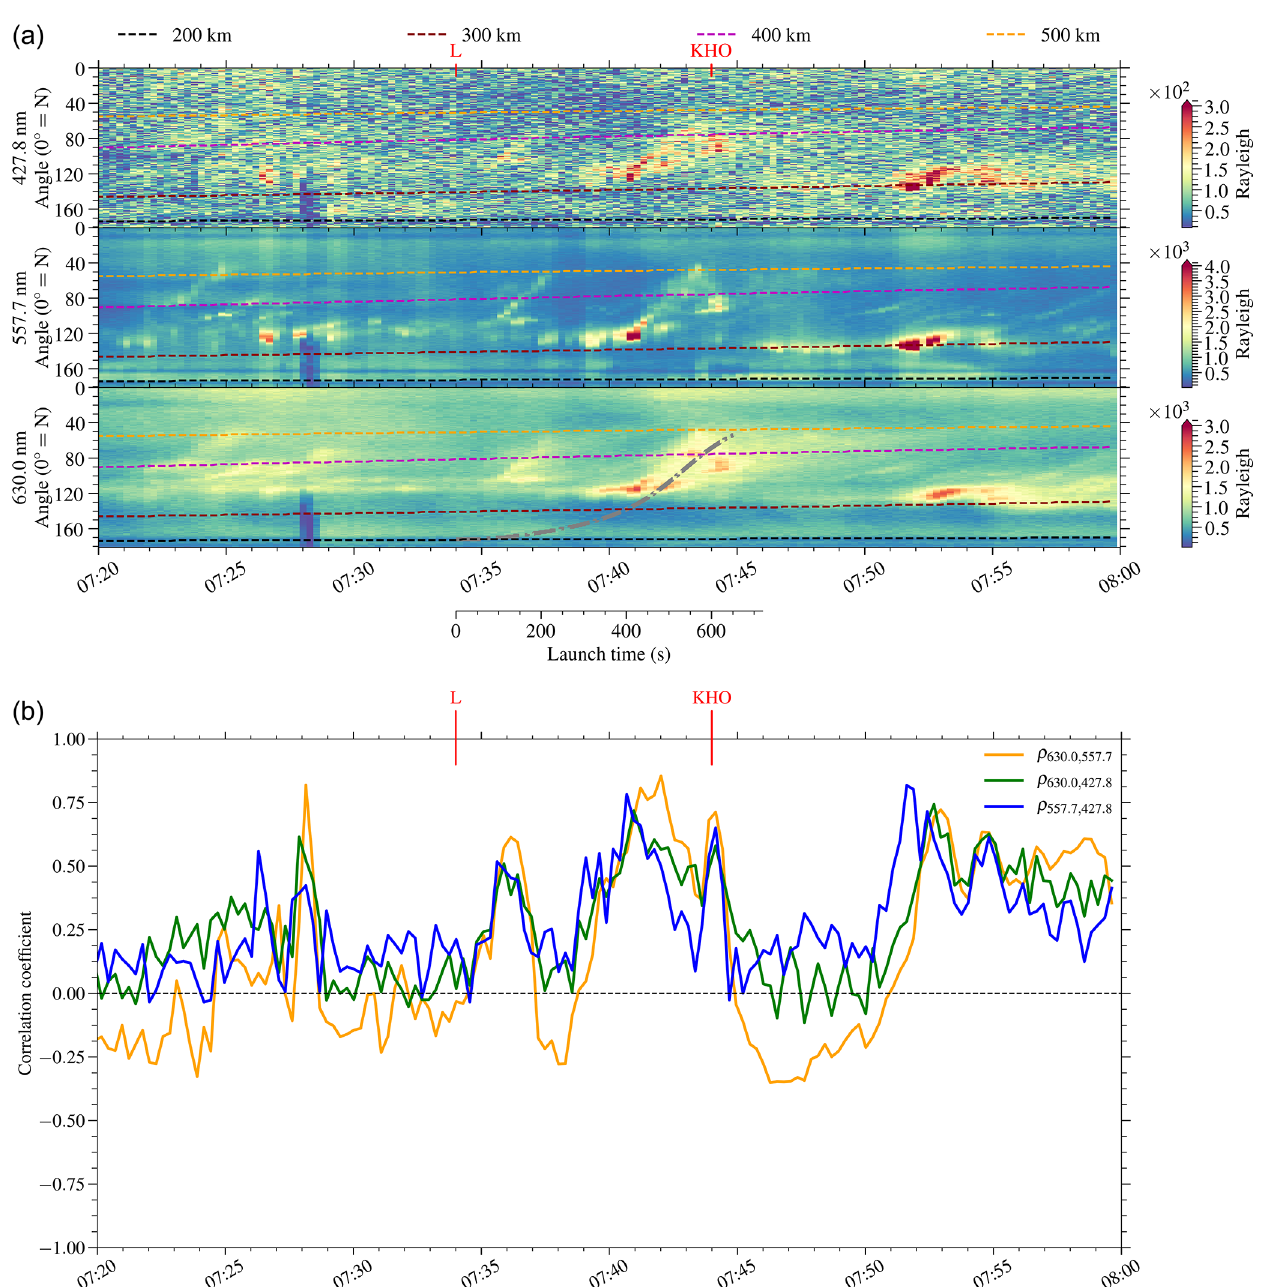
Figure 7. Panel (a) shows the MSP data just before and after the 07:34UTC launch. The vertical blue stripe is due to clearing of snow from the slit. L and KHO mark the launch and passing east of KHO, respectively. Dashed lines represent the sunlit part of the atmosphere, with everything south of the line being sunlit at and above that altitude. Sunlit means that the light from the Sun has not passed below 150km in order to get to the point of interaction. In the 630.0nm subpanel the dashed and dotted grey line represents the rocket track mapped to the MSP field of view at a height of 240km. Panel (b) shows the correlation coefficients for the time around the launch at 07:34UTC based on the data in the top